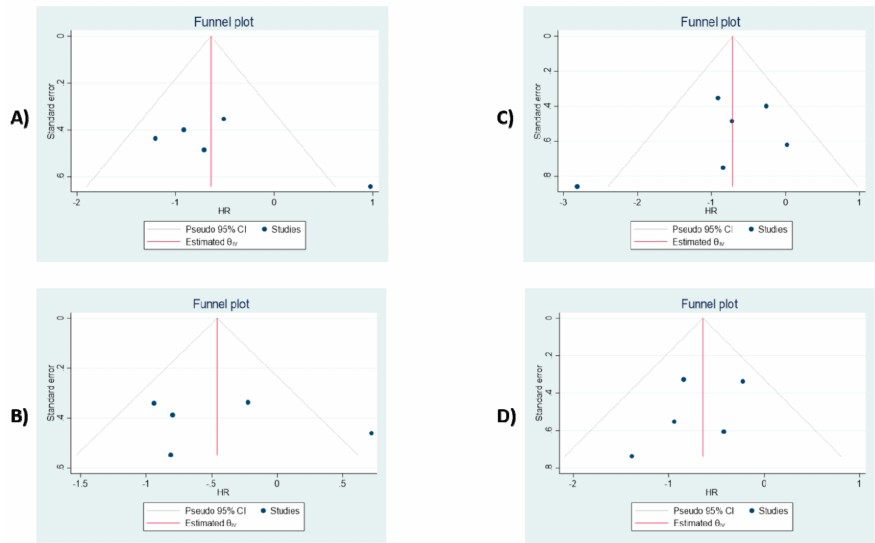
Figure 7. Funnel plot assessment of possible publication bias. ( A ) PD-L1 expression for OS. ( B ) PD-L1 expression for DFS. ( C ) TILs for OS. ( D ) TILs for DFS.